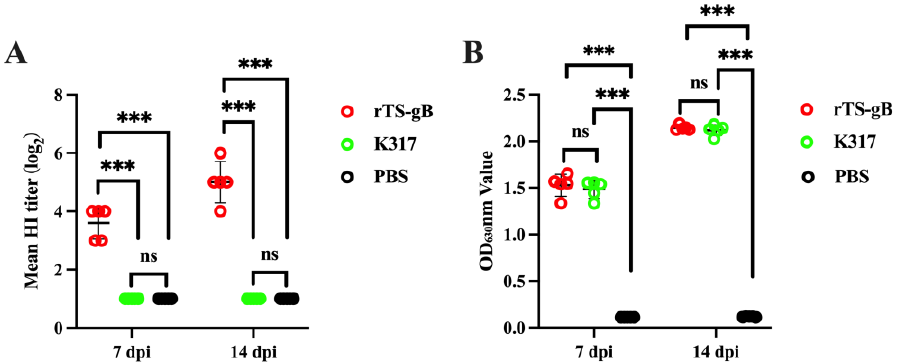
Figure 4. Humoral immune response induced by rTS-gB in chickens. Serum was collected from each bird at 7 and 14 dpi and used for antibody detection. ( A ) The NDV antibody was detected by HI assay. ( B ) The ILTV antibody was detected by ELISA. The data shown are the measured values of five chickens in each group. *** p < 0.001. ns, not significant.